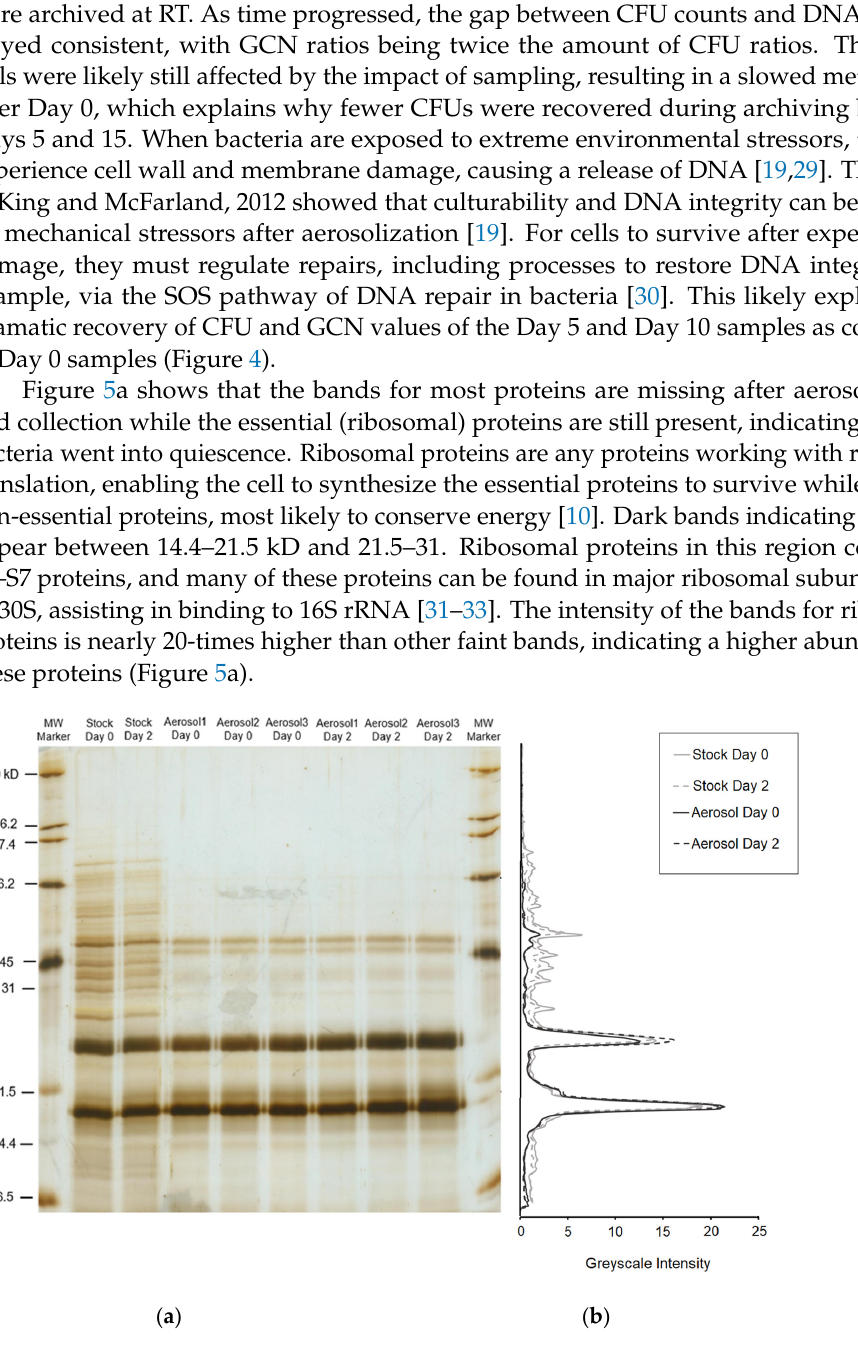
Figure 5. ( a ) Sodium dodecyl sulfate (SDS) gel electrophoresis results stained by the Silver Stain Plus kit (Bio-Rad) show continued protein synthesis of ribosomal proteins and a lower synthesis of non-essential proteins. ( b ) The greyscale intensity showing the peaks in bands of proteins for stock and aerosol samples, also indicating the kD values of the marker without including the peaks for easier visibility.